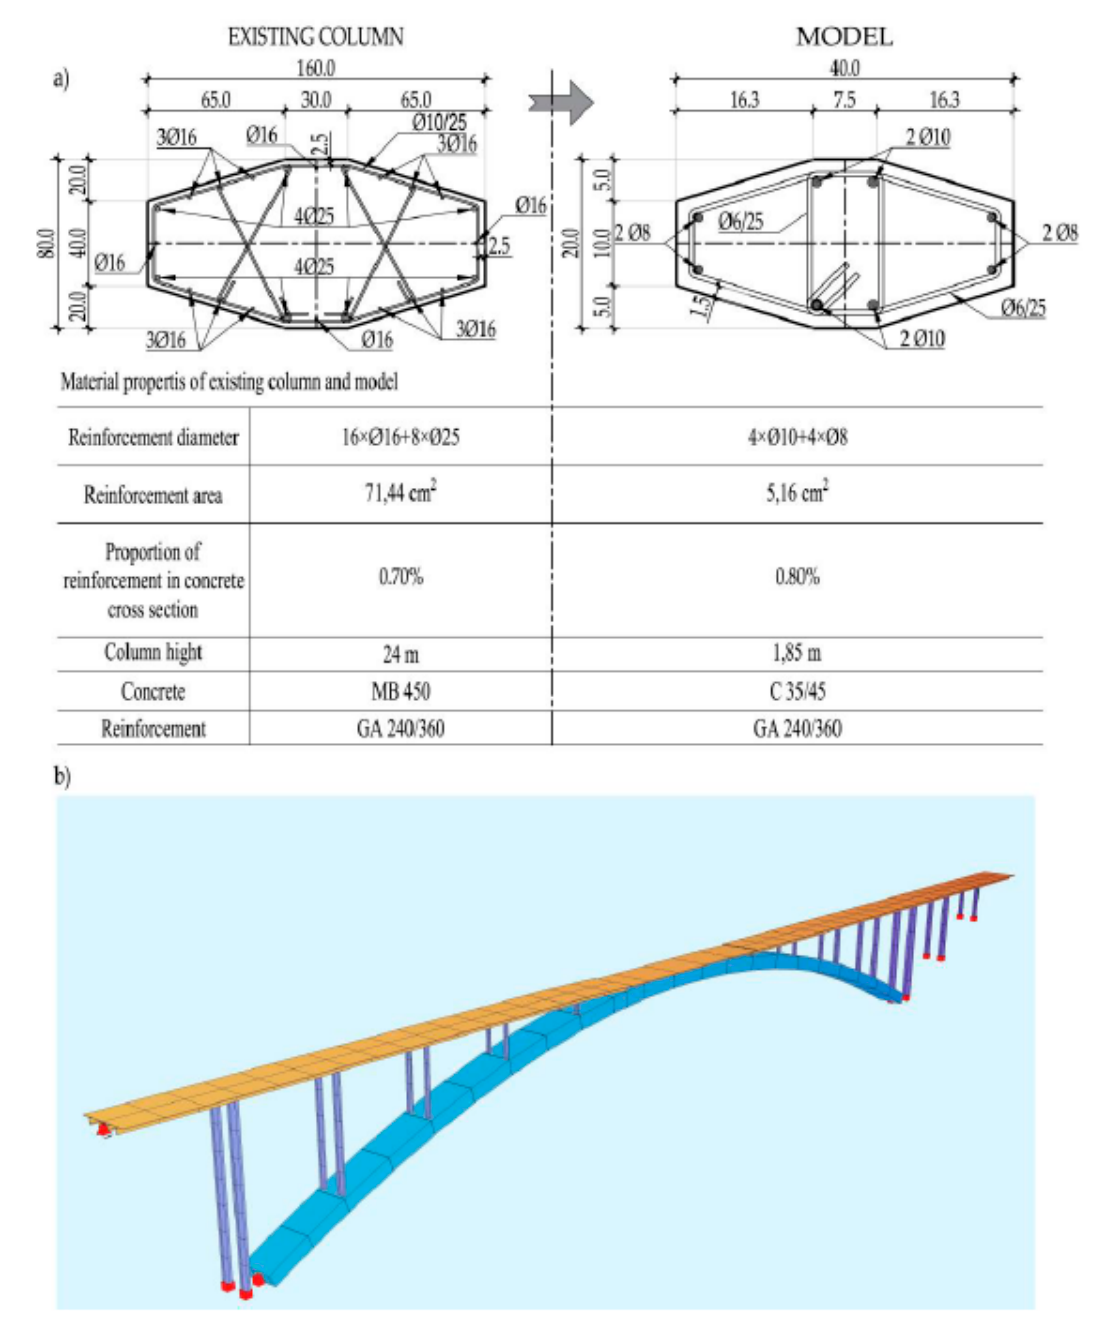
Figure 1. ( a ) The comparison of geometric and material properties of the existing column and model, ( b ) global bridge model for assessment of actions on columns.